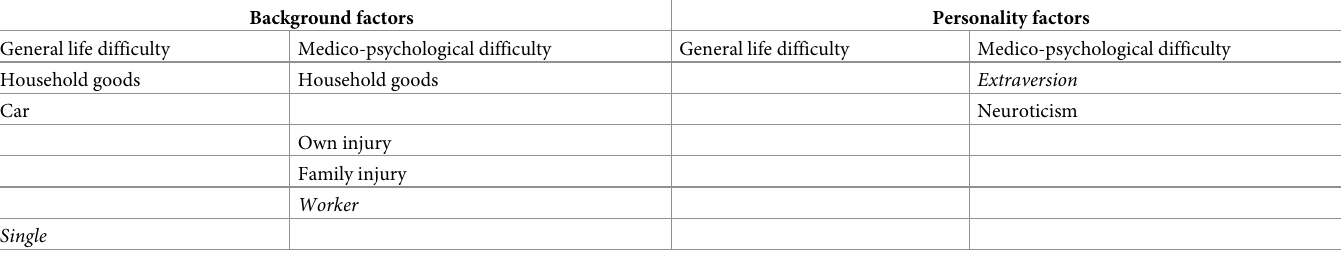
Table 2. Exacerbating factors for two difficulty